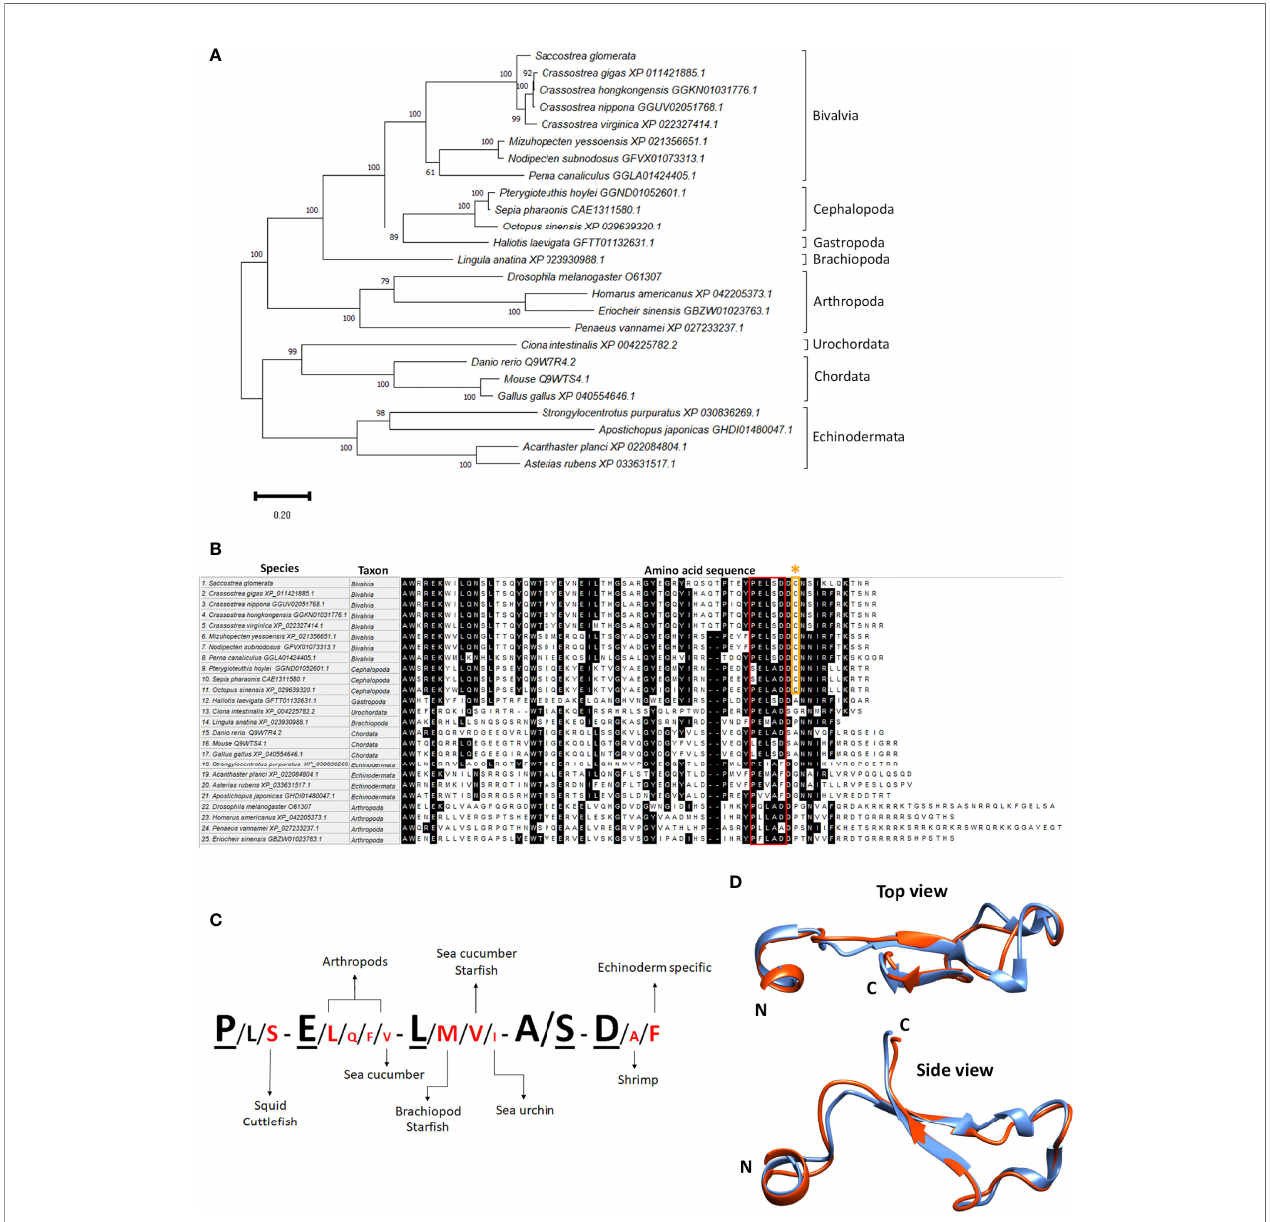
FIGURE 2 | Teneurin/TCAP sequence analysis. (A) Phylogenetic tree of various invertebrates and vertebrates showing relationship based on teneurins, analyzed using Maximum Likelihood, 1000 bootstrap. (B) Homology alignment of TCAP sequences from invertebrates and vertebrates using MUSCLE, highlighting amino acid residues where >50% homology is observed. The red box shows the conserved motif among invertebrates and vertebrates. The orange asterisk shows the conserved cysteine residues among bivalvia and chepholopoda. (C) Conserved TCAP residues in various species show species speci fi city. Underlined residues- SRO and bivalve speci fi c, red residues- newly identi fi ed in molluscs, echinoderms and arthropods. The size of residues re fl ects the relative level of conservation between the species investigated. The larger the size, the higher frequency a speci fi c residue appears in the dataset and vice versa. (D) 3D model alignment of predicted sroTCAP with human TCAP-2, showing a top and side view. Blue ribbon- sroTCAP, red ribbon- human TCAP-2. N and C depict the N- and C- terminus,